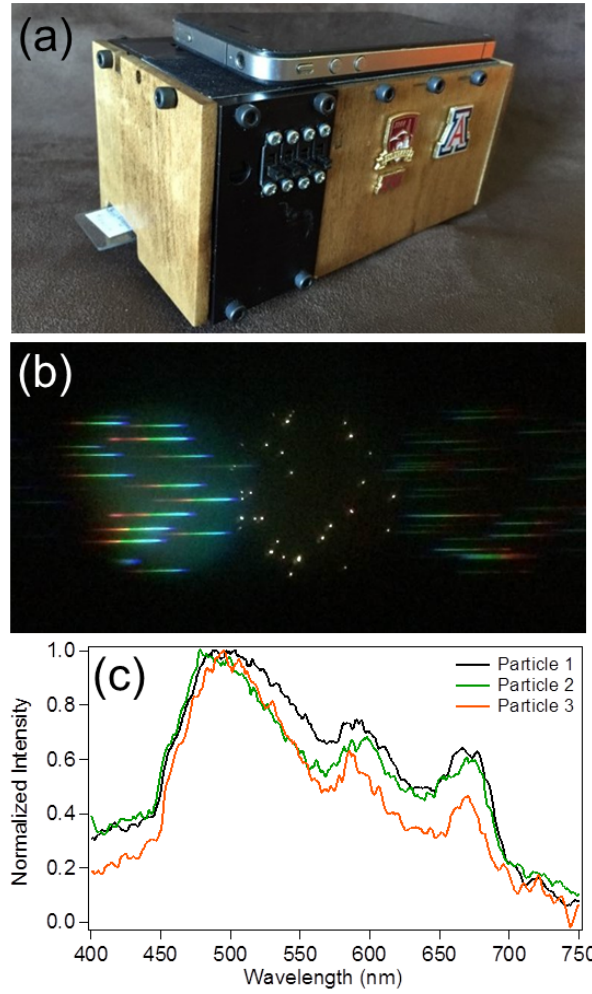
Figure 7. Smartphone spectrofluorometer prototype. (a) Photo- graph of iPhone spectrometer. (b) Standard micrograph (dots in cen- ter) and fluorescence swaths (on left and right) collected as single image with iPhone 5s shown in panel (a) using 10 × objective. Par- ticles are Kentucky bluegrass pollen ( Poa pratensis ). (c) Spectra of three of the particles from panel (b) , normalized to peak height of 1.0. As shown, field of view is a 2mm circle. Approximate distance from objective lens to camera is